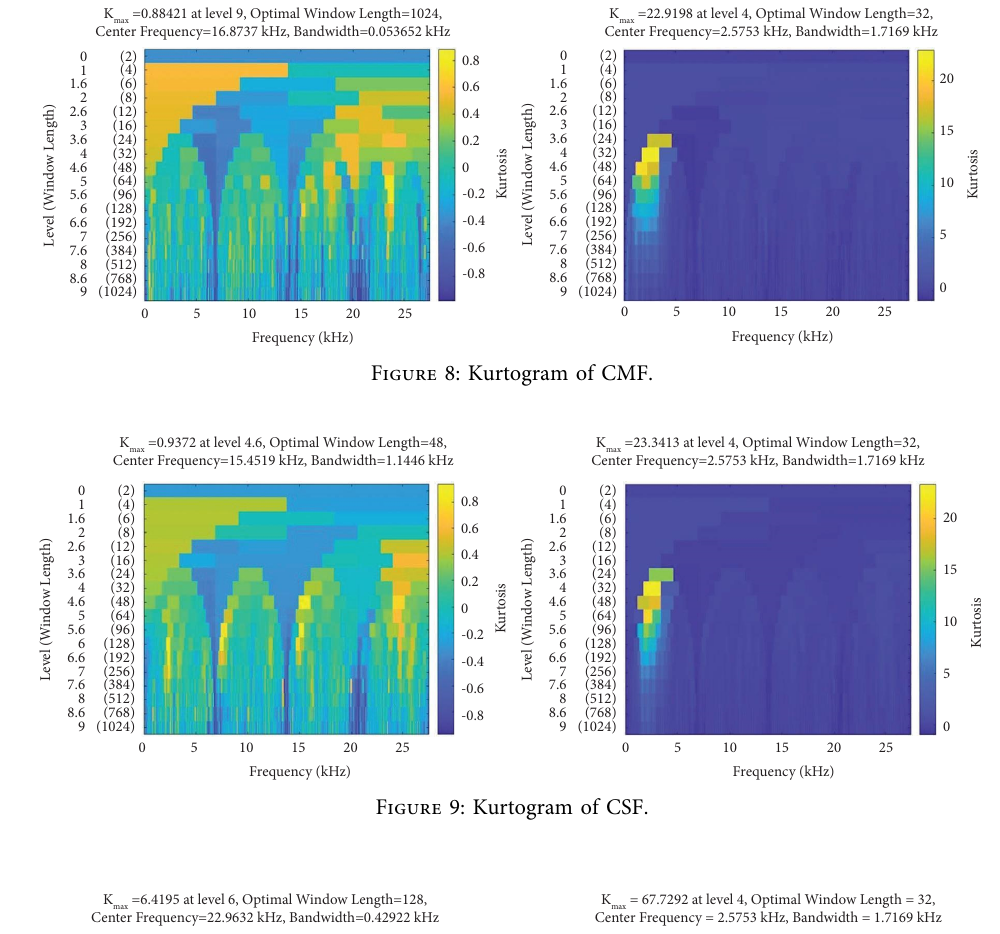
Figure 9: Kurtogram of CSF.